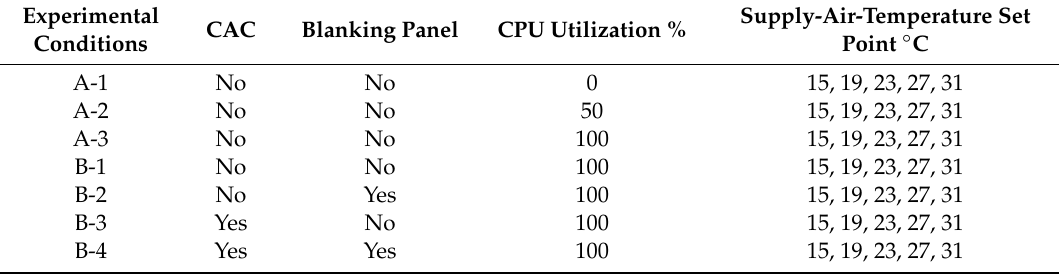
Table 5. Experimental conditions (experiments A and